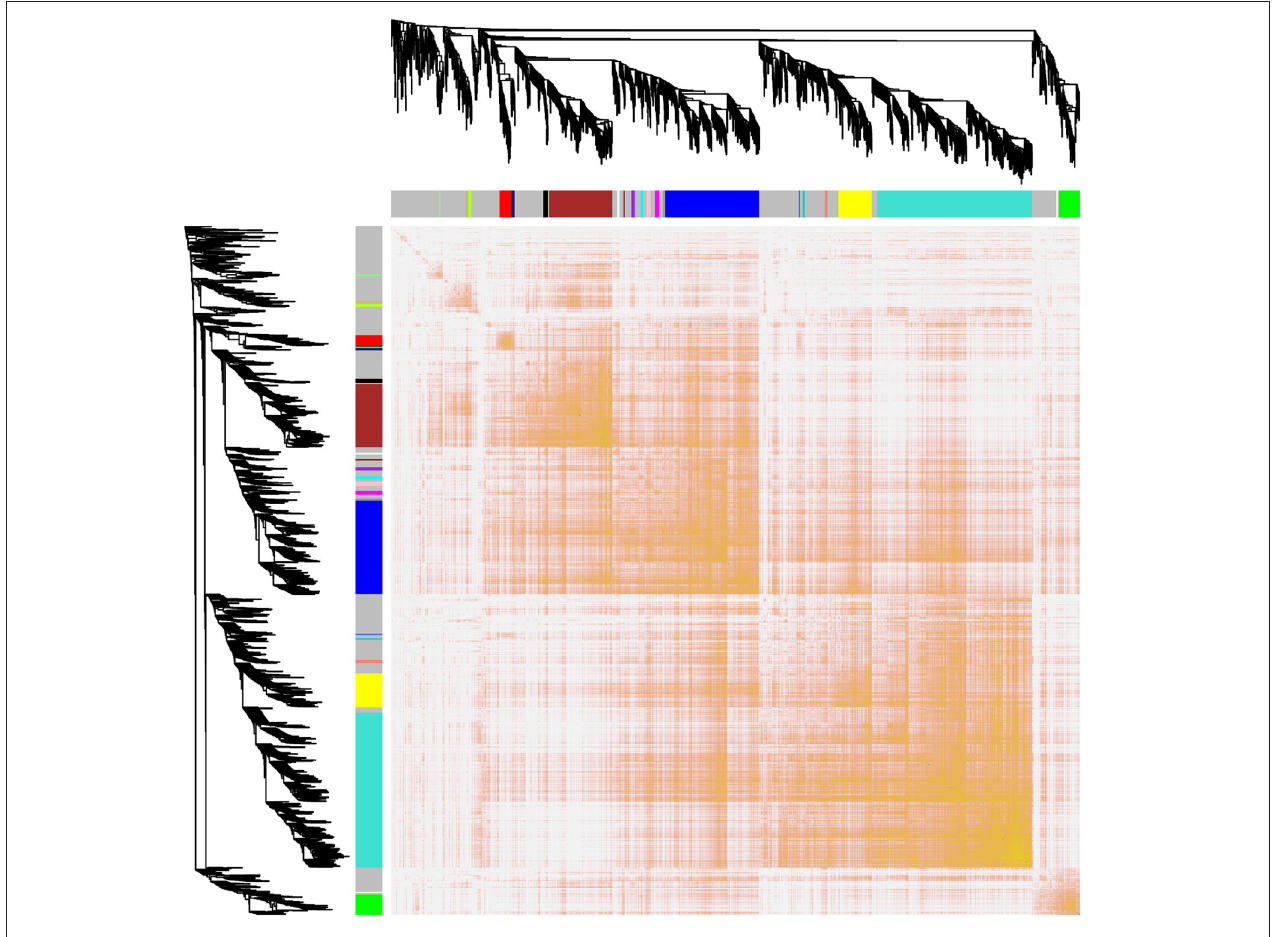
FIGURE 3 | Interaction relationship analysis of coexpressed genes. Different colors of the horizontal axis and vertical axis represent different modules. The brightness of yellow in the middle represents the degree of connectivity of different modules. There was no significant difference in interactions among different modules, indicating a high degree of independence among these